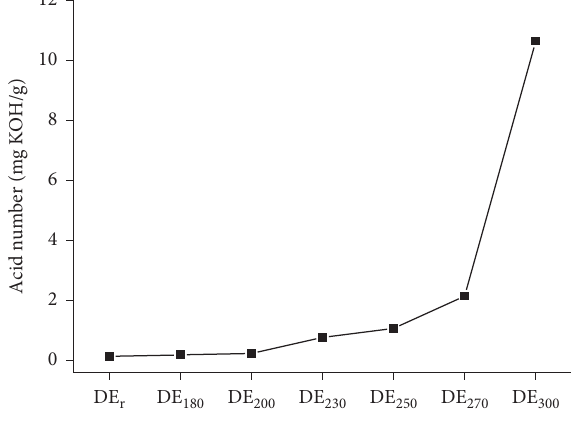
Figure 5: AN values of oil